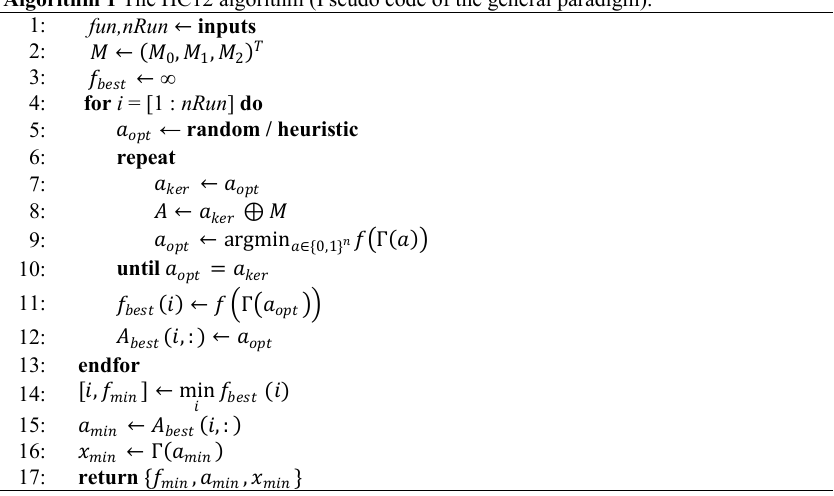
Algorithm 1 The HC12 algorithm (Pseudo code of the general